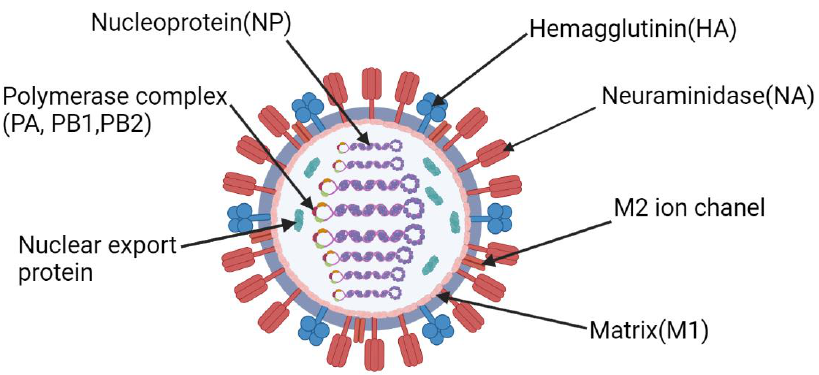
Figure 1. Structure of the influenza virus. Figure was created using BioRender tool.